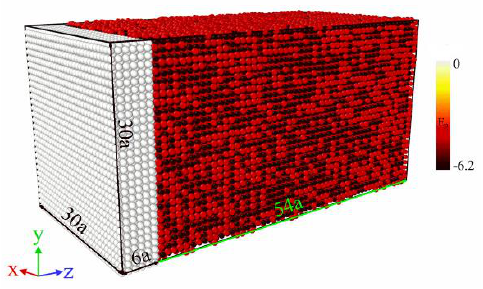
Figure 4. MD simulation model of piston impact loading.